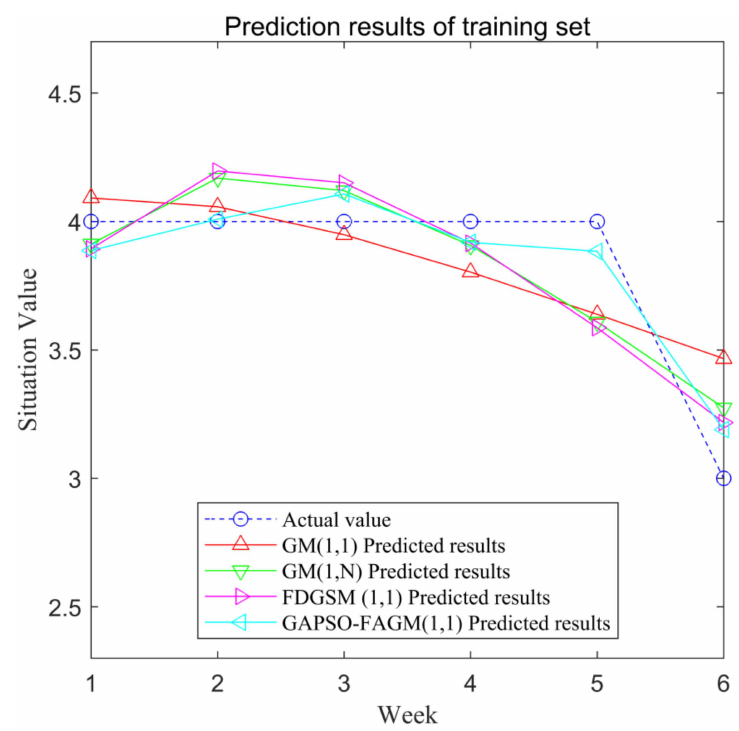
Figure 4. Prediction results of the training set.